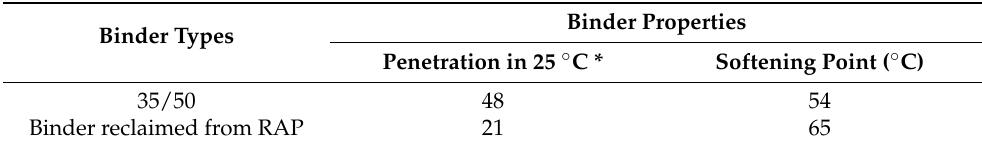
Table 2. Properties of binders used in mixtures.